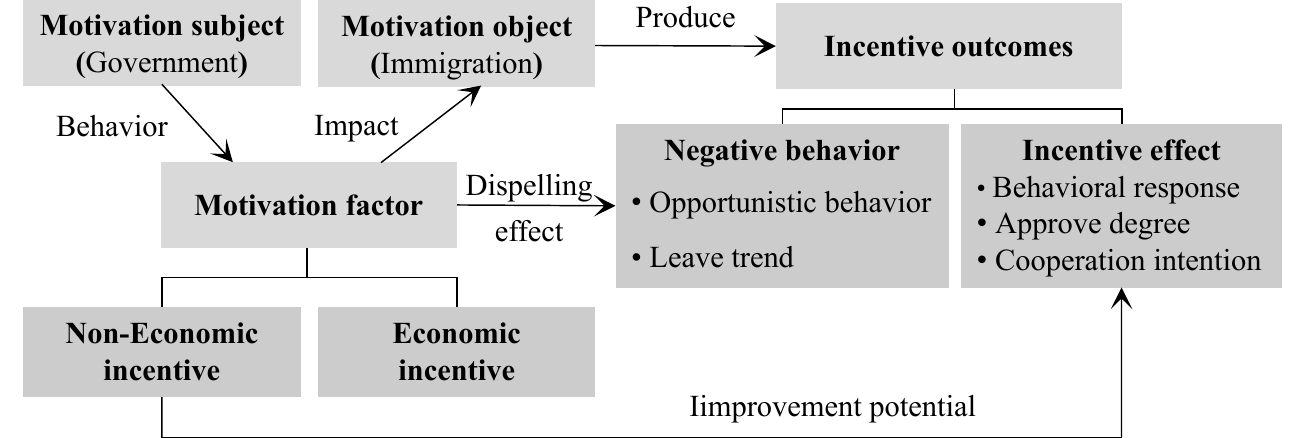
Figure 4. Framework of immigration incentive mechanism model.